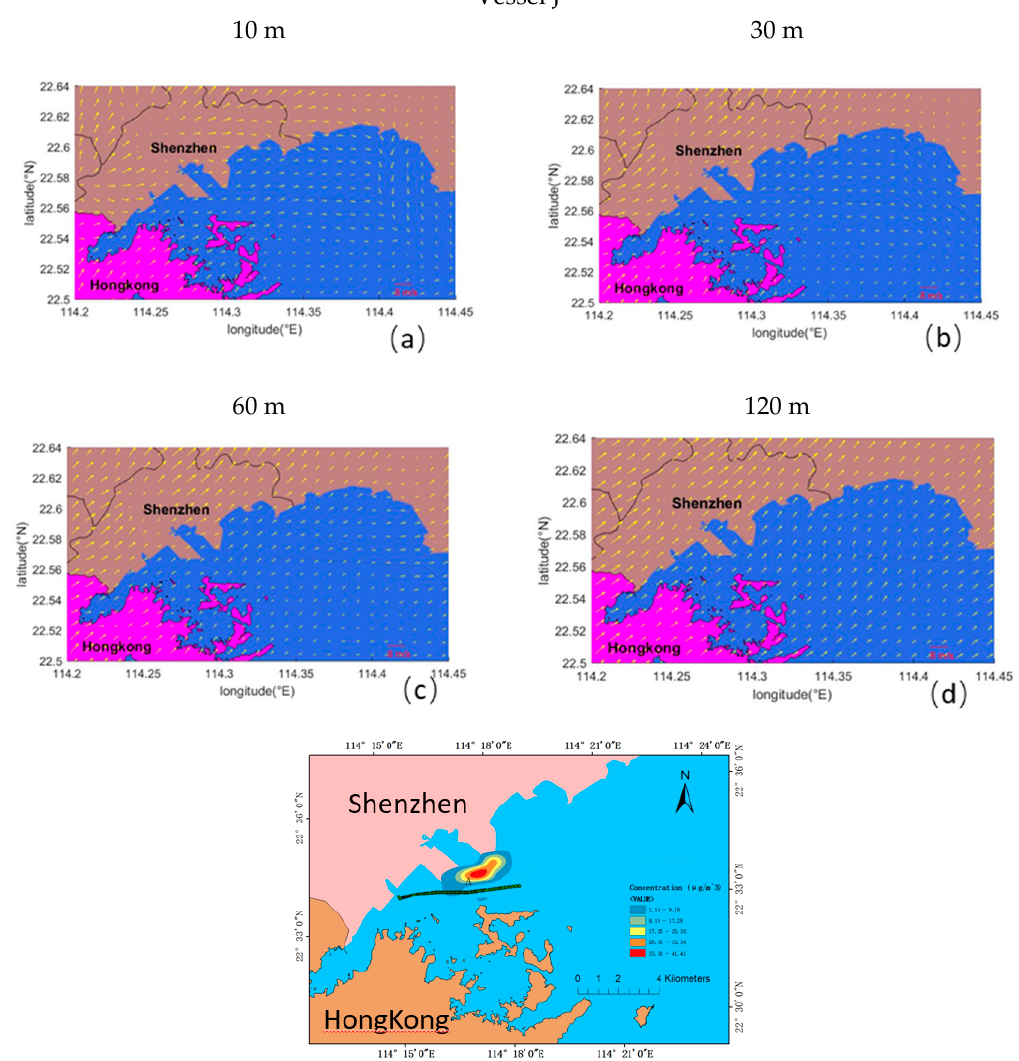
Figure A11. Wind field at different heights at the departure stage of Vessel J and the spatial distribution of the maximum concentration of each simulation grid during the simulation period. ( a ) 10m, ( b ) 30m, ( c ) 60m and ( d ) 120m.